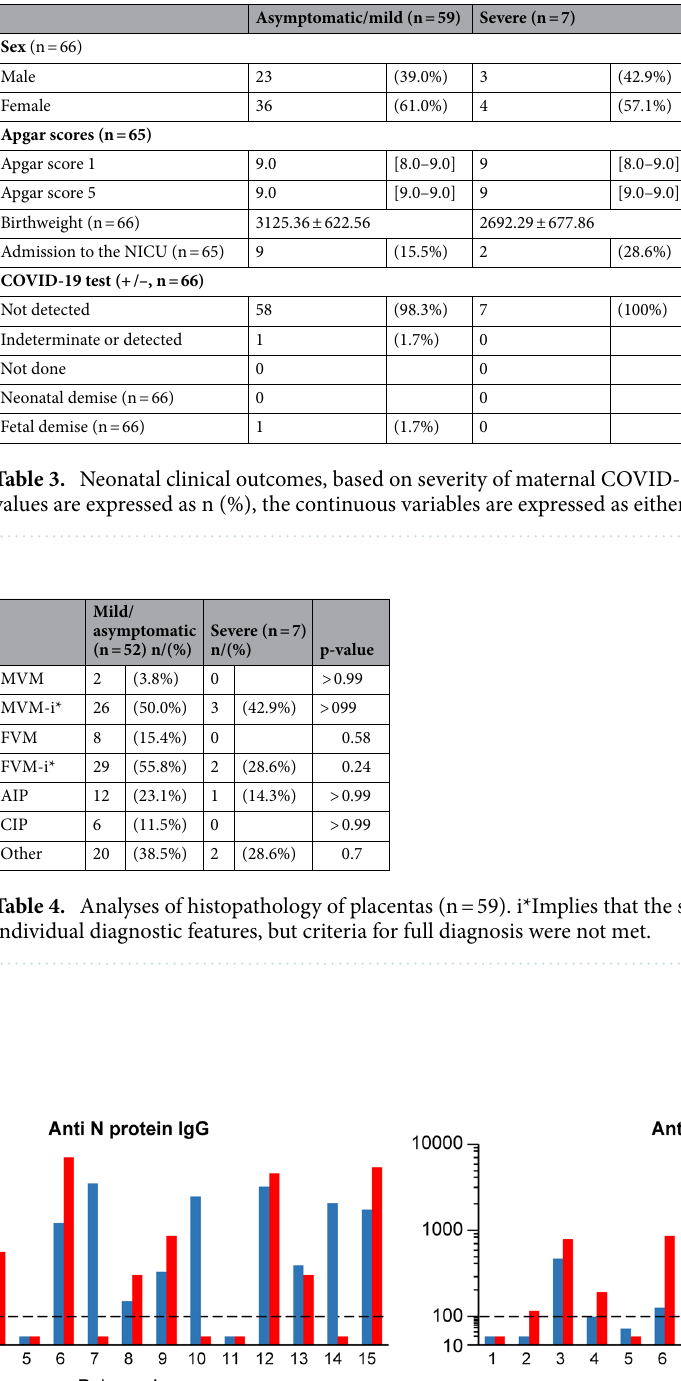
SARS-COV-2 in the placenta of two participants, one with asymptomatic/mild and one with severe COVID-19. Using all suitable RNA samples, we measured placental expression of mRNAs for SARS-CoV-2 entry factors,